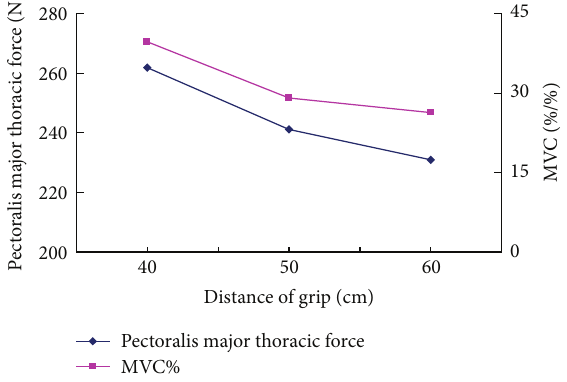
Figure 5: The relation between the maximum stress and pectoralis major MVC%